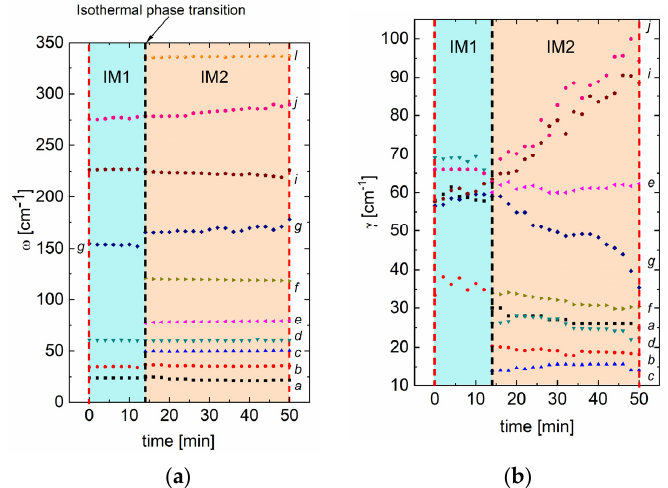
Figure 6. ( a ) Raman frequency and ( b ) damping factor of calculated modes, as a function of time for PbZrO3:0.1Nb crystal at 233 °C. The black dashed line corresponds to the isothermal phase transition. The red dashed lines correspond to the time span of the measurement at 233 °C in Figure 4.